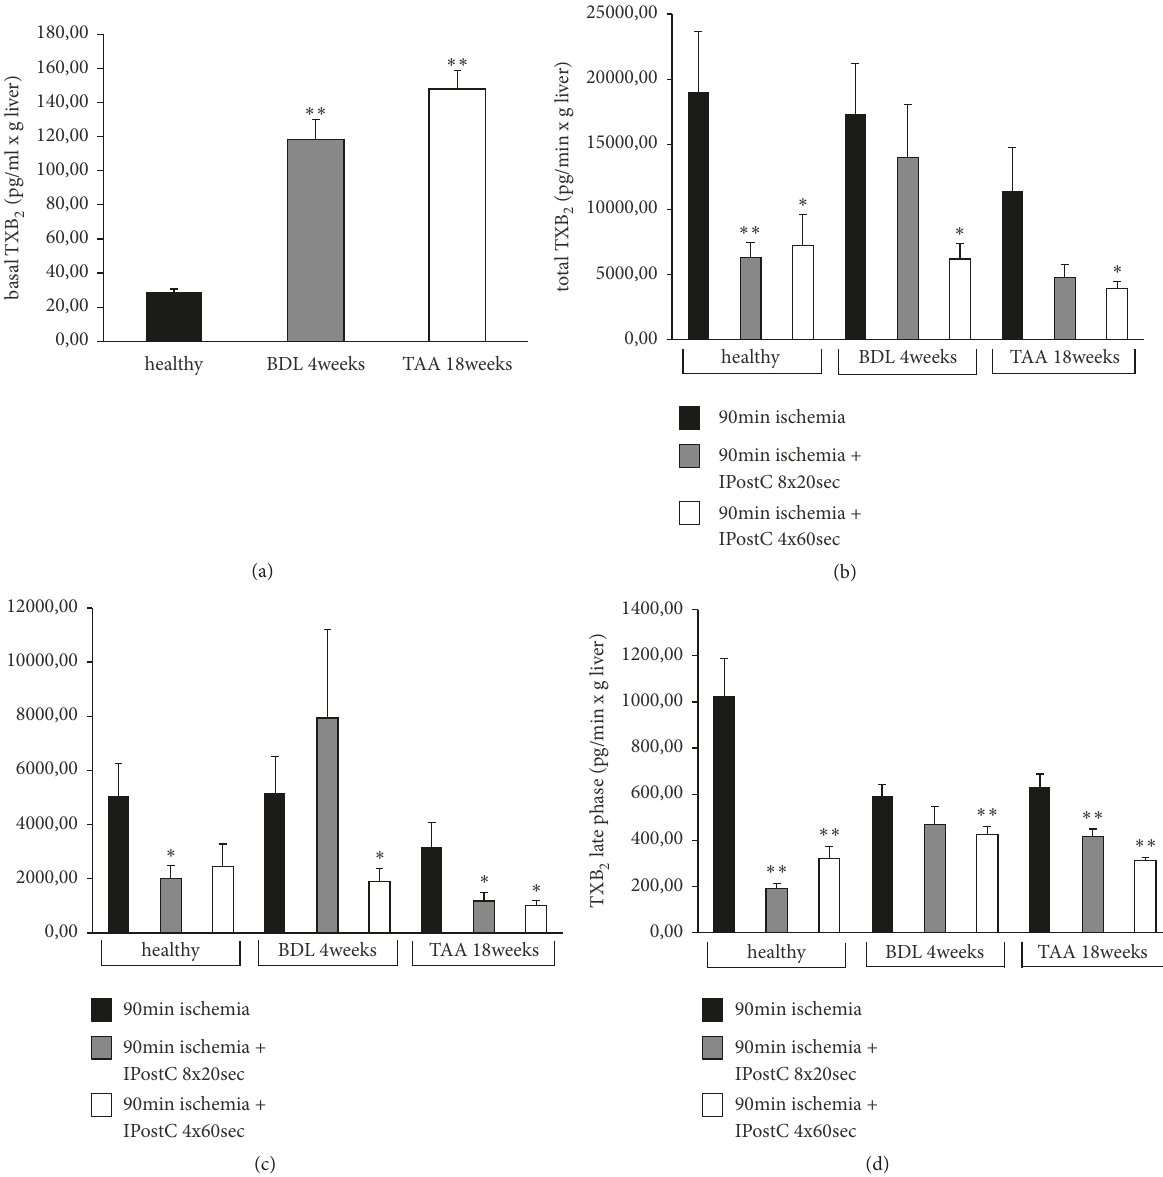
of IPostC probably does not reach all liver lobes equally.